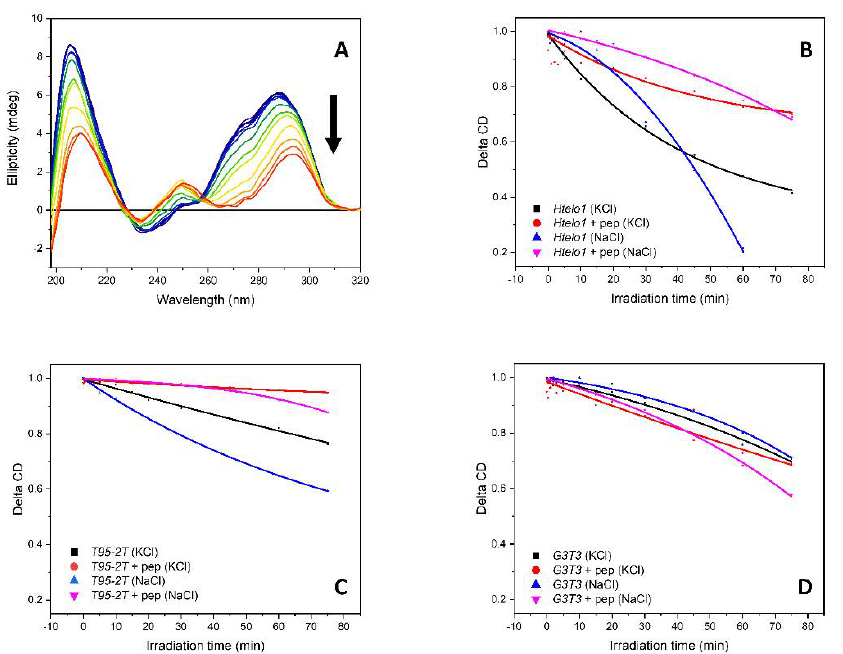
Figure 12. ( A ) CD spectra G-quadruplex sequence (as example, Htelo1 13.5 μM in 10 mM Tris-HCl buffer, pH 7.4, in presence of 70 mM potassium ions) as a function of irradiation time with the arrow representing the direction of the spectral change as irradiation time is increased. Normalized rates of denaturation of G-quadruplex-forming sequences with and without the Rhau25 peptide in 70 mM potassium or sodium ions; ( B ) for Htelo1 ; ( C ) for T95-2T ; ( D ) for G3T3 .